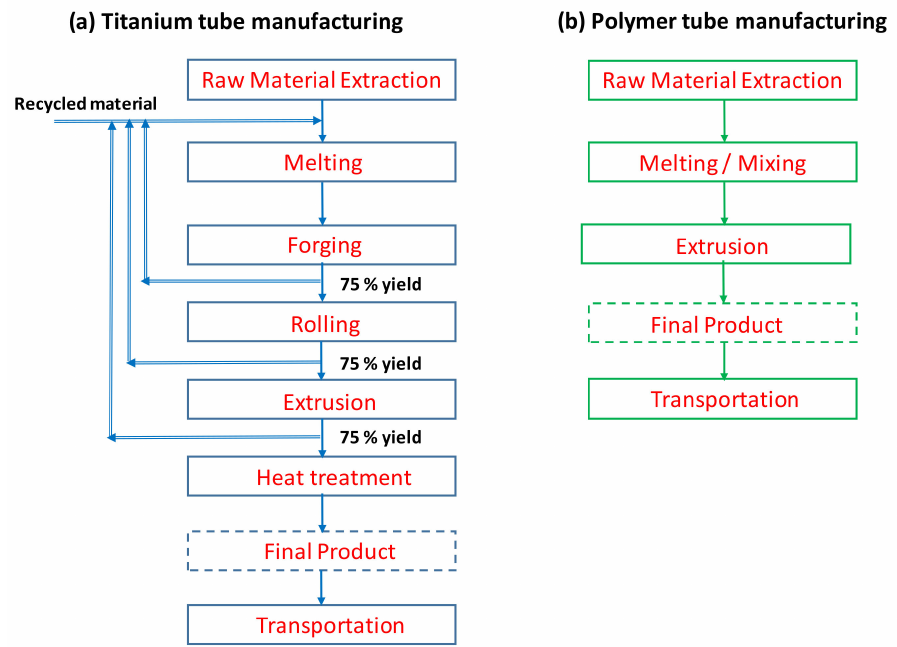
Figure 3. Tube manufacturing processes for ( a ) titanium and ( b ) thermally enhanced polymer. The life-cycle inventory (LCI) analysis stage compiles the input and output data asso- ciated with the system boundary to produce metallic and polymer tubes. LCI accumulates the specific energy and material details that are exchanged among different